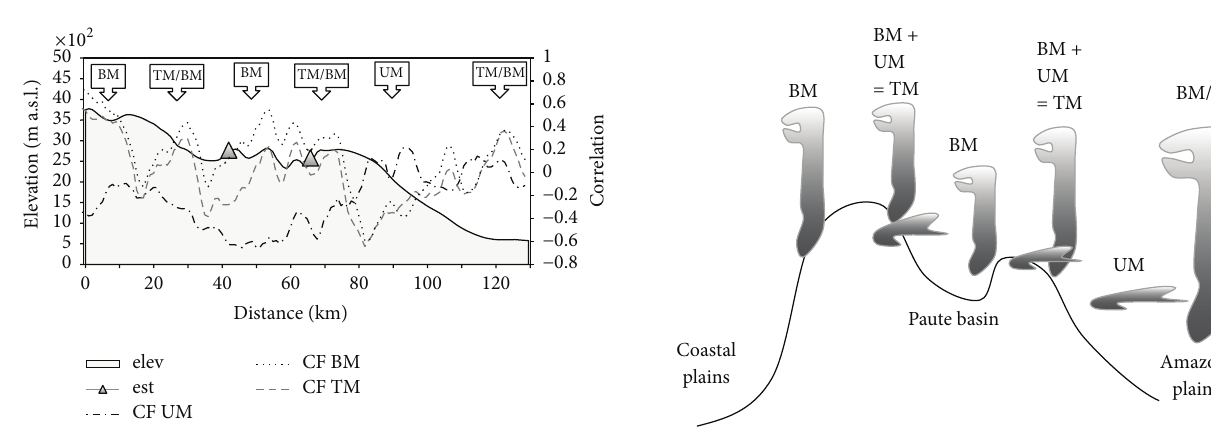
Figure 8: Conceptual model of seasonal rain formation for the Rio Paute catchment